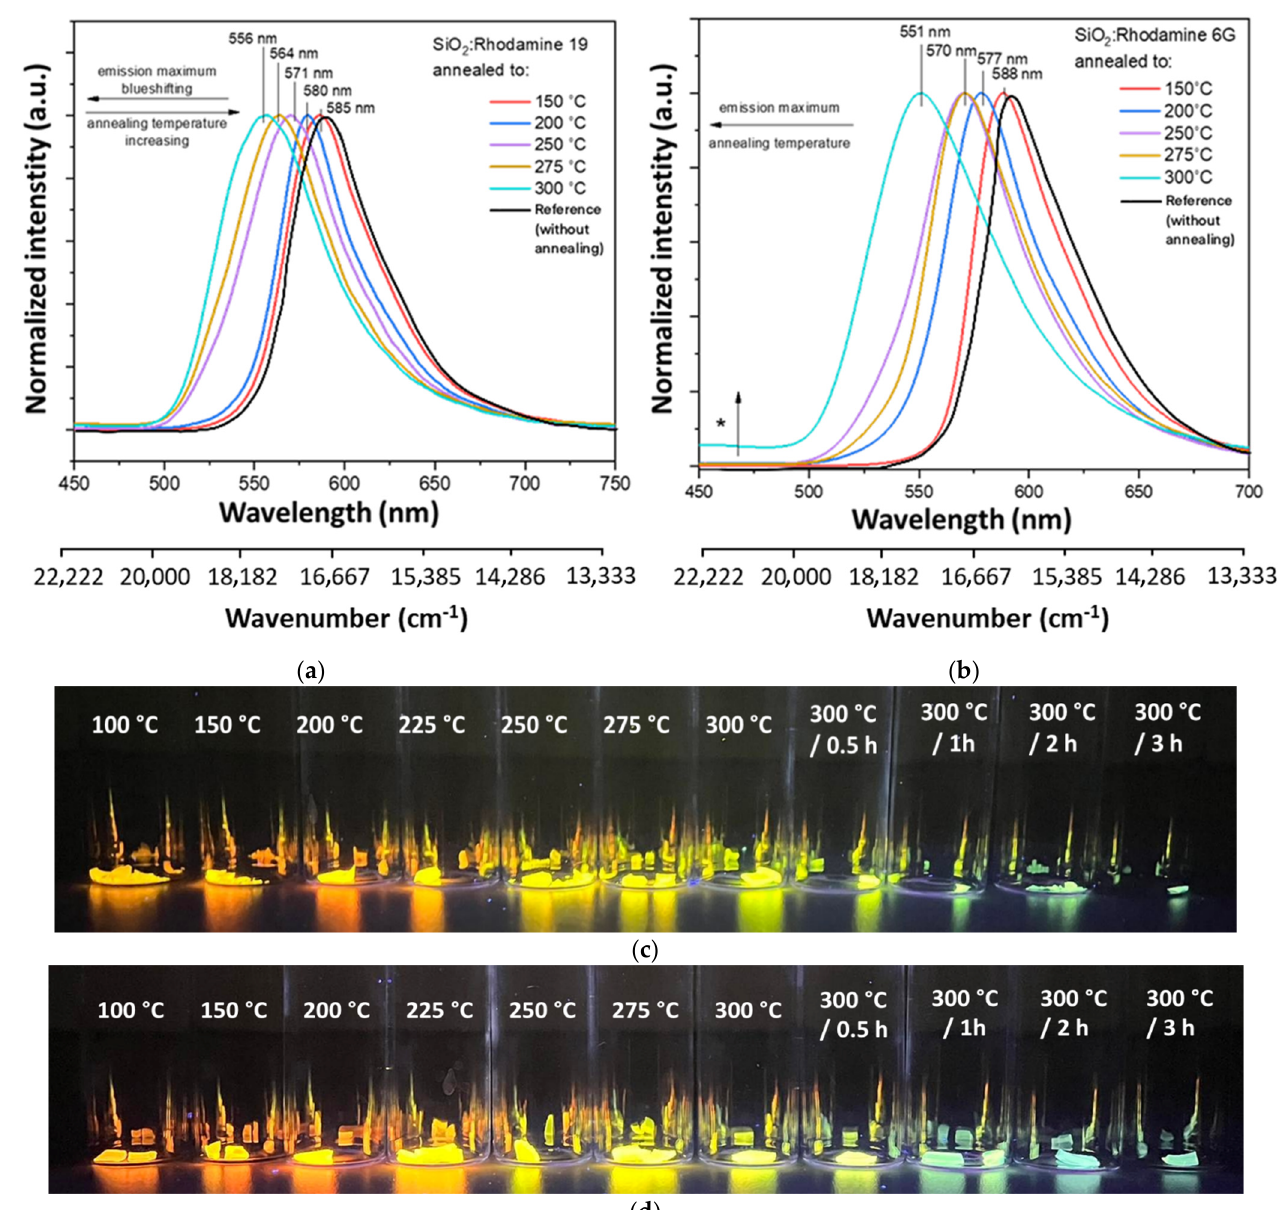
Figure 1. Normalized emission spectra for gels annealed from 150 °C to 300 °C for 10 min, λ ex = 280 nm. Marked with an asterisk − an additional band associated with emission from silica matrix: ( a ) SiO 2 : Rhodamine 19; ( b ) SiO 2 : Rhodamine 6G. Photograph of samples upon excitation with UV lamp λ ex = 360 nm impregnated with dye: ( c ) Rhodamine 19; ( d ) Rhodamine 6G.